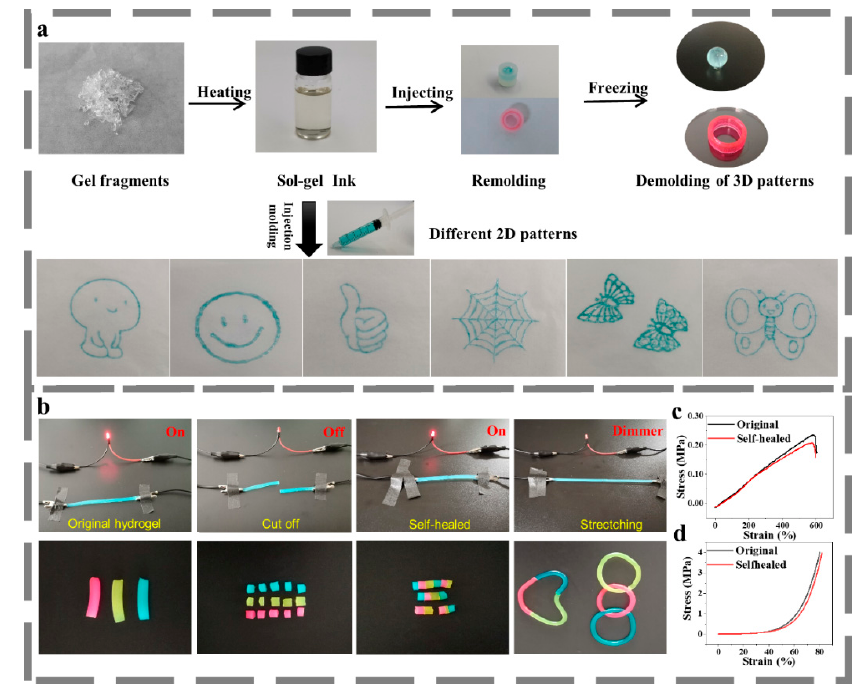
Figure 4. Thermoplastic performance and self-healing ability of PVA-HEDP hydrogels. ( a ) Ther- moplastic behavior of PVA-HEDP hydrogels, ( b ) Self-healing process of the hydrogel, ( c ) Tensile stress–strain curves of PVA-HEDP hydrogel before and after self-healing, ( d ) Compressive stress- strain curves before and after self-healing.